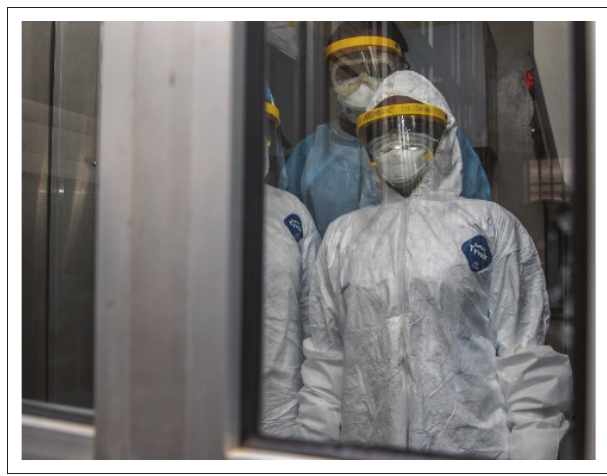
Source : Photo courtesy of the Nigeria Centre for Disease Control FIGURE 1: In the time of COVID-19. The importance of laboratory medicine has been made more visible by COVID-19 than at any time this